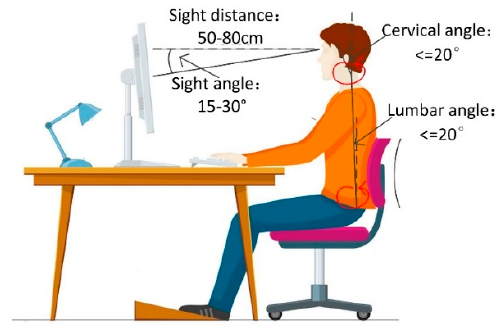
Figure 5. The definition of healthy sitting posture based on ergonomics.